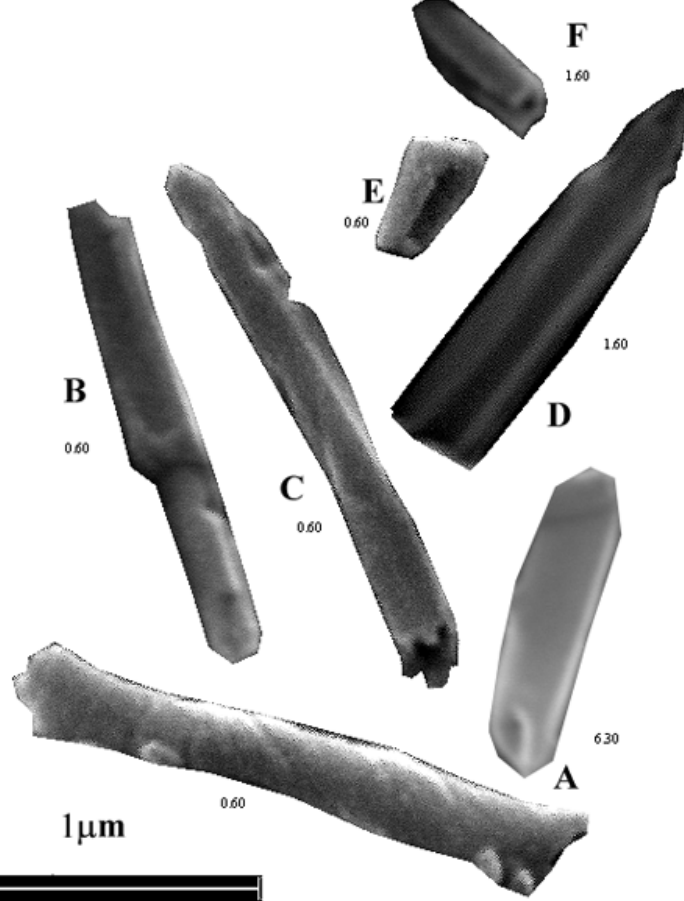
Fig. 11 – Observed morphological changes in the halloysite particles: Tubes (A), tubes with planar faces with internal cylindrical holes (B), tubes with internal and external planar faces (C), unrolling tubes (D, E, F). The sequence of changes in morphology (A → B → C → D → E) due to dehydration of halloysite, evolves into platy kaolin particles. Small numbers correspond to position in meters of depth in the